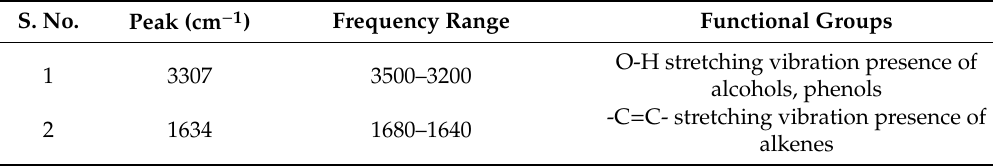
Table 3. FTIR spectra of M. esculenta leaves ethyl acetate extract.